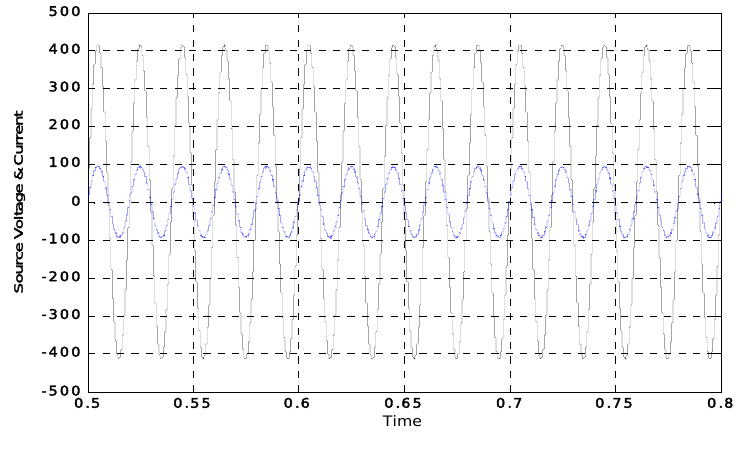
Figure 6. “Source Voltage & Current at